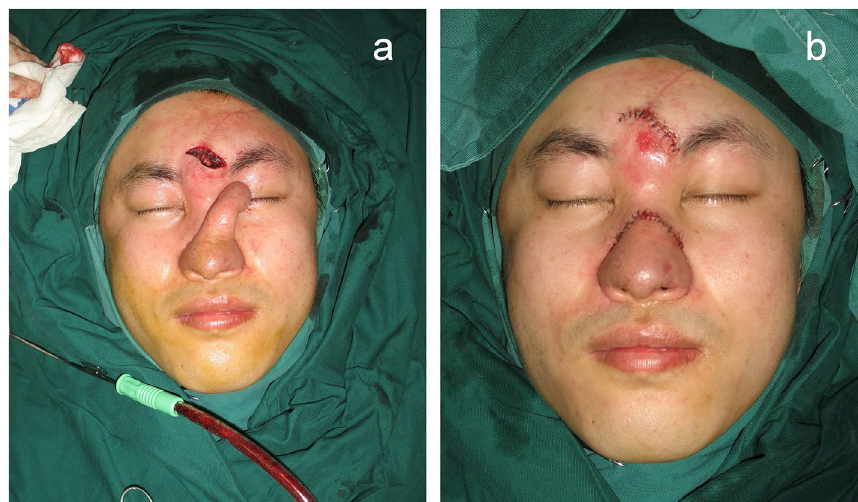
Figure 5. ( a ) Resection of the pedicle. ( b ) Restoration and closure of the defect (same patient in Fig.